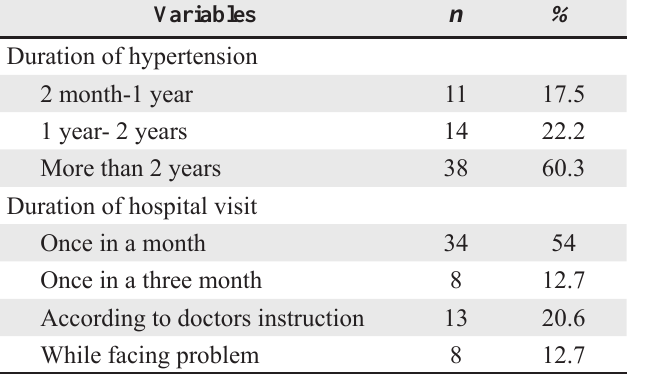
Table 2 : Frequency Distribution of participants according to hypertension related variables